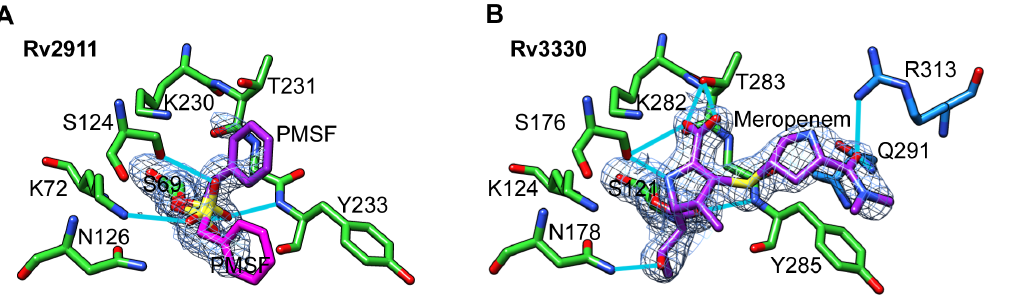
Fig. 3. Conserved arrangement of catalytic-site residues of Rv2911 and Rv3330 peptidases. A. Rv2911opt-PMSF. Electron-density (2Fo-Fc, 2.0-A˚ resolution, 1 s ) shows the inhibitor adopts two major conformations (purple and magenta). B. Rv3330-meropenem. Electron-density (2Fo-Fc, 2.0-A˚ resolution, 1 s ) supports a unique model with extended interactions between the inhibitor (purple) and the enzyme. Common catalytic residues are colored green and Clade 2 conserved residues in Rv3330 are colored